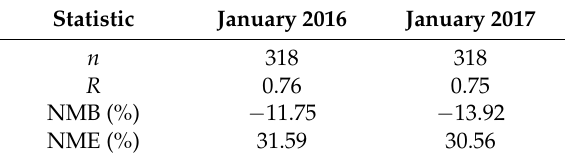
Figure 2. Simulated and observed PM 2.5 concentrations in January 2016 ( a ) and January 2017 ( b ). Table 5. Performance statistical parameters for PM 2.5 concentration simulations in China.